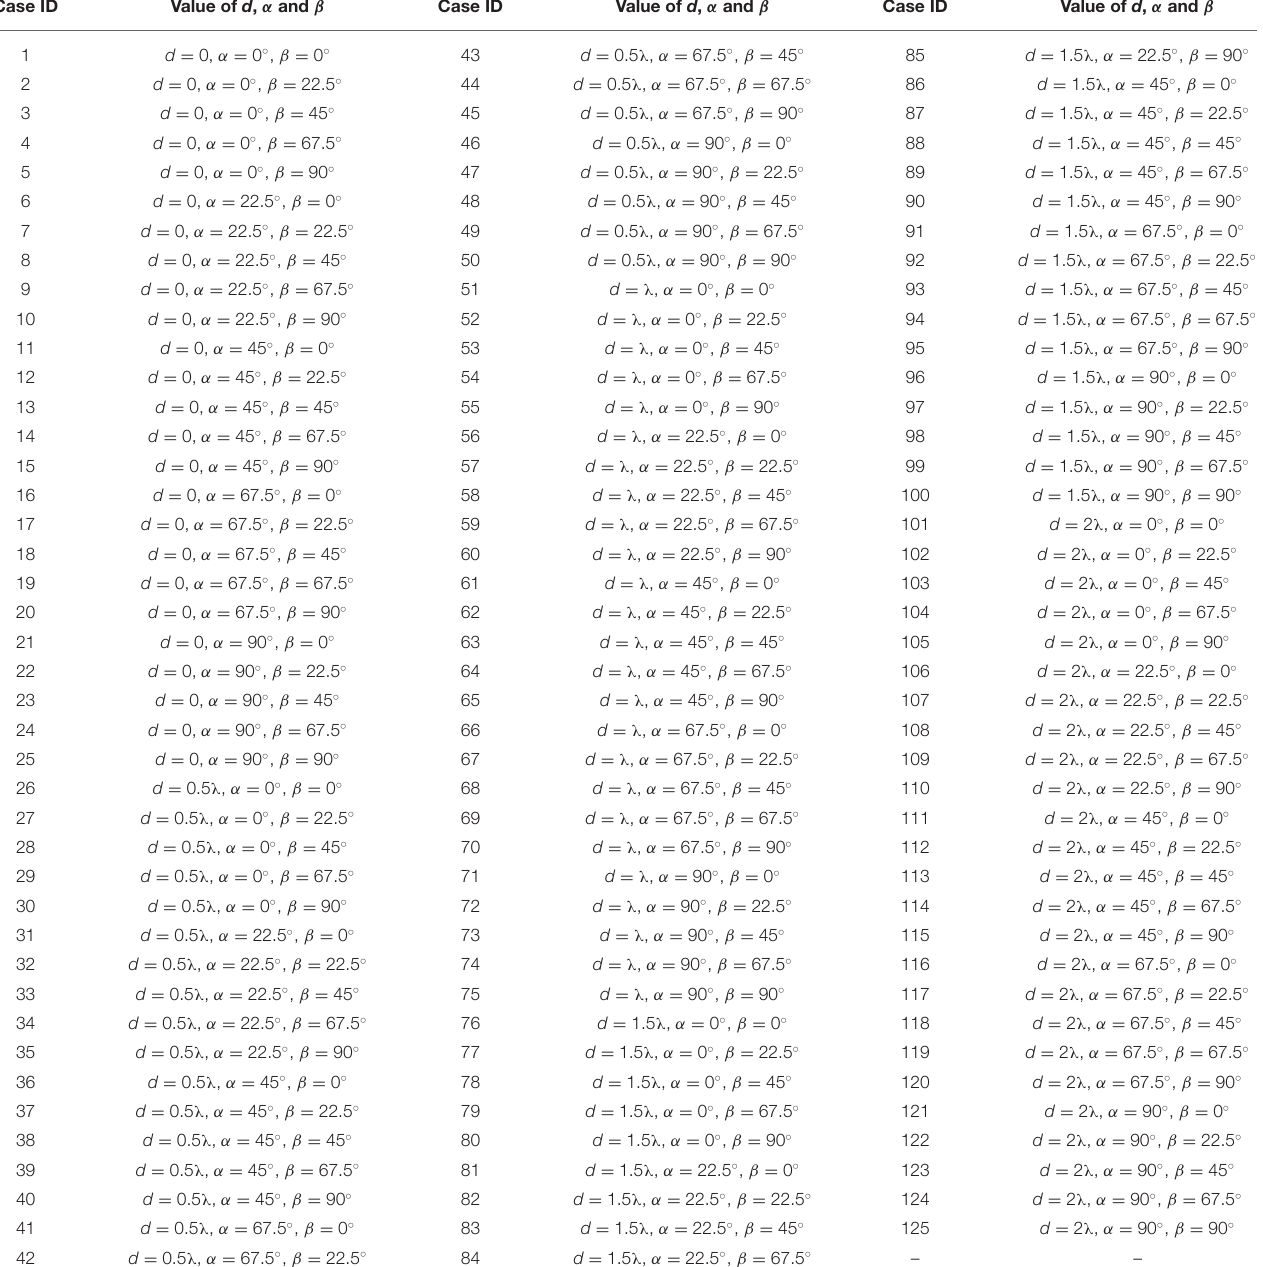
TABLE 1 | Case ID corresponding to the 125 relative posture positions of the two